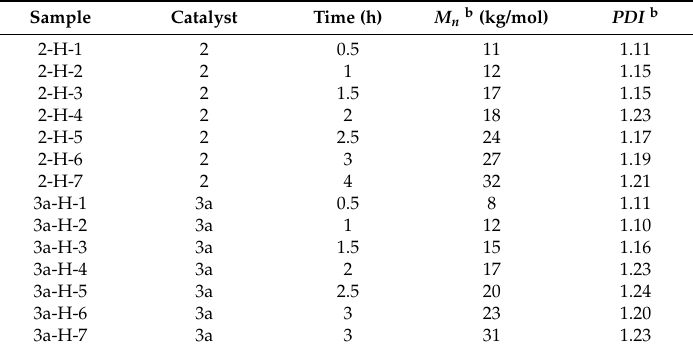
Table 6. 1-Hexene polymerization using 2 and 3a in CH 2 Cl 2 a